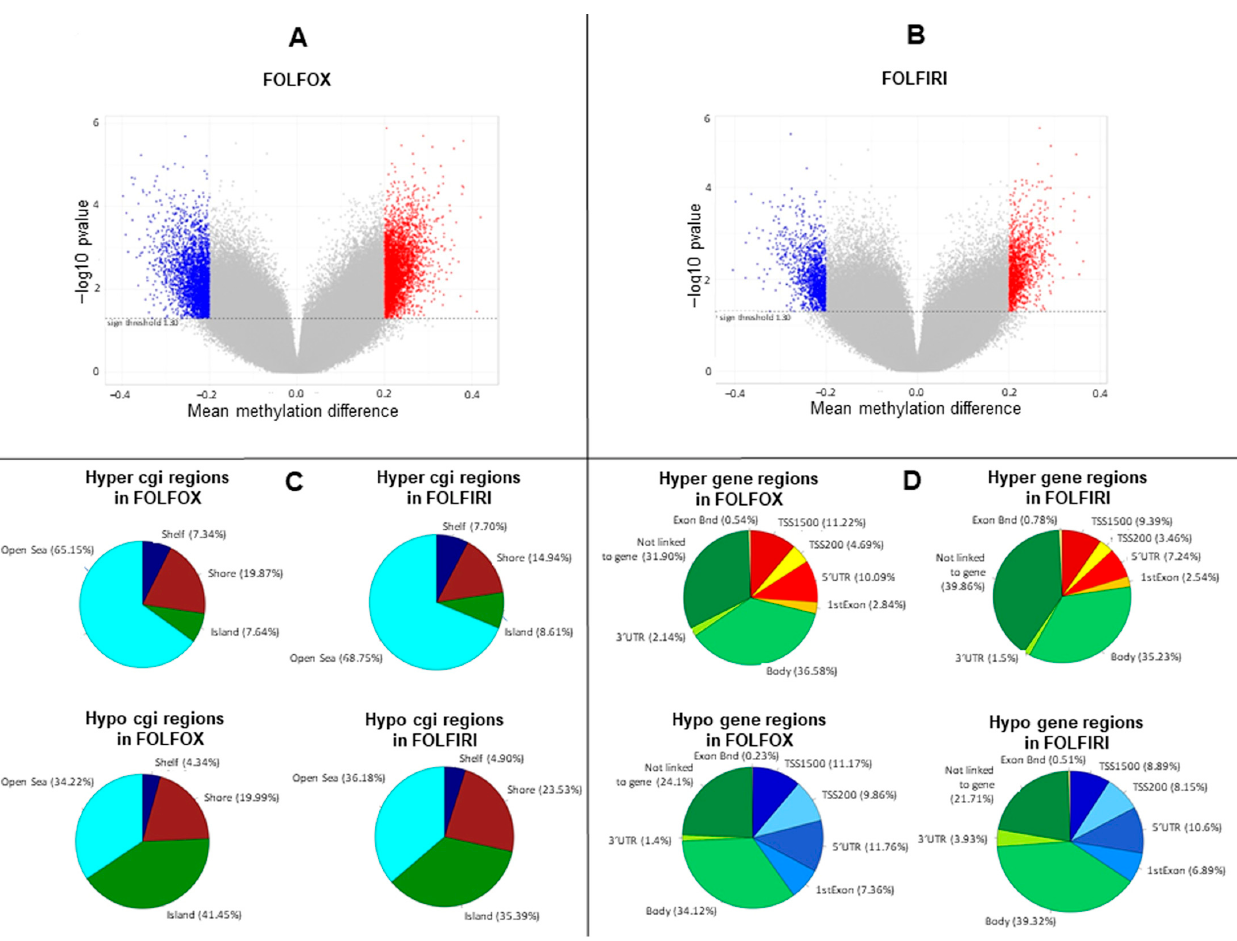
Figure 1. Methylation profile is remodeled in primary-resistant versus drug-sensitive metastatic colorectal carcinomas (mCRCs). ( A , B ). Volcano plots representing differentially methylated probes between primary-resistant and drug-sensitive mCRCs. Overall, statistically significant differentially methylated probes were 74,843 and 36,876 in, respectively, FOLFOX and FOLFIRI datasets ( p -value < 0.05). In particular, statistically significant probes with an absolute difference of Beta value > 0.2 are highlighted as blue dots, corresponding to hypomethylated probes (3227 in FOLFOX and 1475 in FOLFIRI datasets), or as red dots, corresponding to hypermethylated probes (3899 in FOLFOX and 1393 in FOLFIRI datasets). ( C , D ). Differentially methylated probes distribution according to genomic regions.